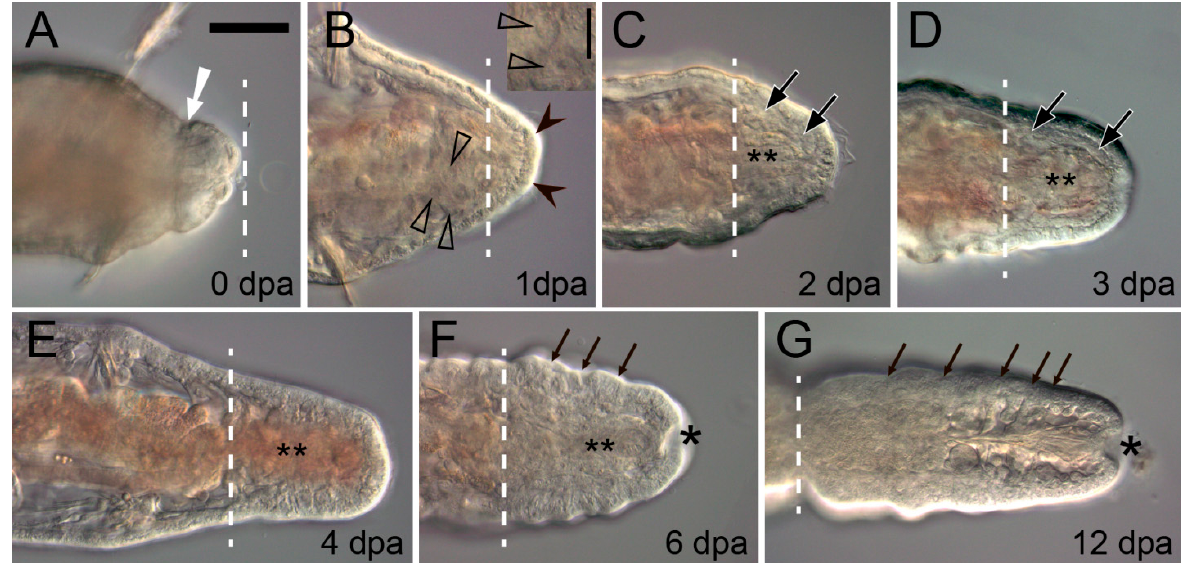
Figure 2. Posterior regeneration in the juvenile oligochaete Tubifex tubifex (Clitellata, Naididae). Optical frontal sections of live anesthetized specimens 0 to 12 dpa; posterior end is to the right. Dotted line, plane of amputation; double asterisk, gut lumen; white arrow in ( A ), constriction of circular muscles; triangles in ( B ), numerous large spindle-shaped cells with a large nucleus and a nucleolus at the end of cut VNC (higher magnification view on the insert); black arrowheads in ( B ), wound epithelium covering the whole stump; large arrows in ( C , D ), mesodermal cells of the regeneration blastema, which is already segmented at 4 dpa ( E ); asterisk in ( F , G ), anus; small arrows in ( F , G ), segmental boundaries. Scale bar in ( B , insert) 20 μ m, in all other panels 50 μ m.